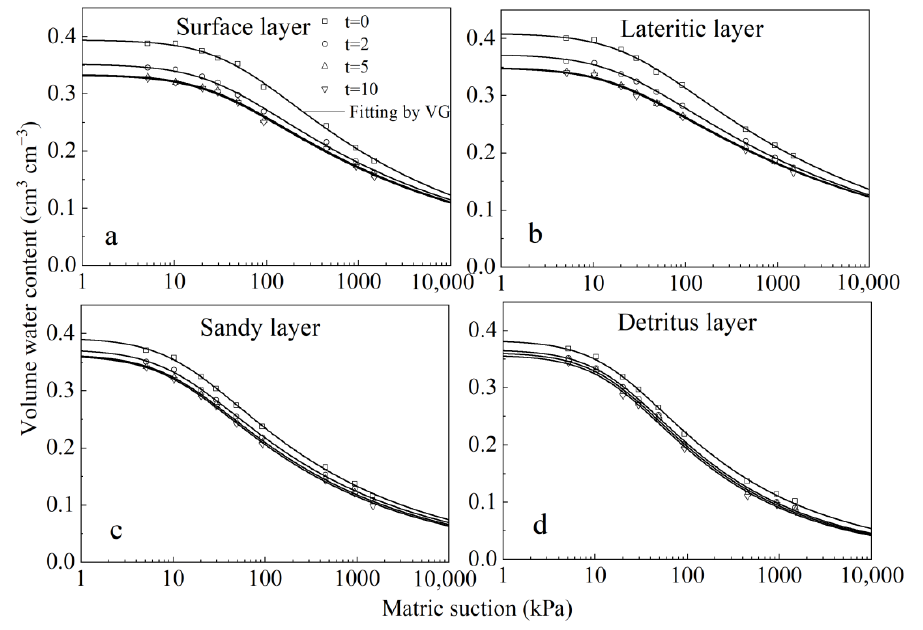
Figure 4. Soil water characteristic curves of experimental soils under W-D cycles ( a – d ) represent soil water characteristic curves of experimental soils of surface layer, lateritic layer, sandy layer and detritus layer, respectively.